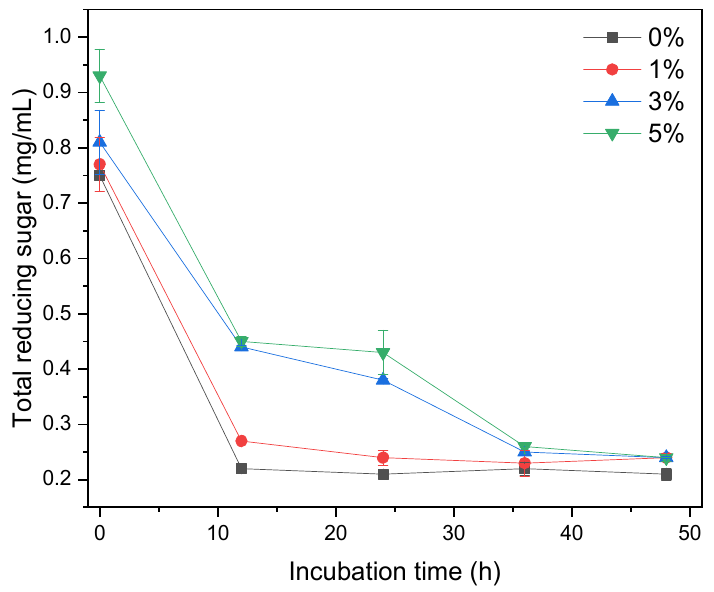
Figure 4. Total reducing sugar content in MRSm media with different concentration of XOS as a function of incubation time.